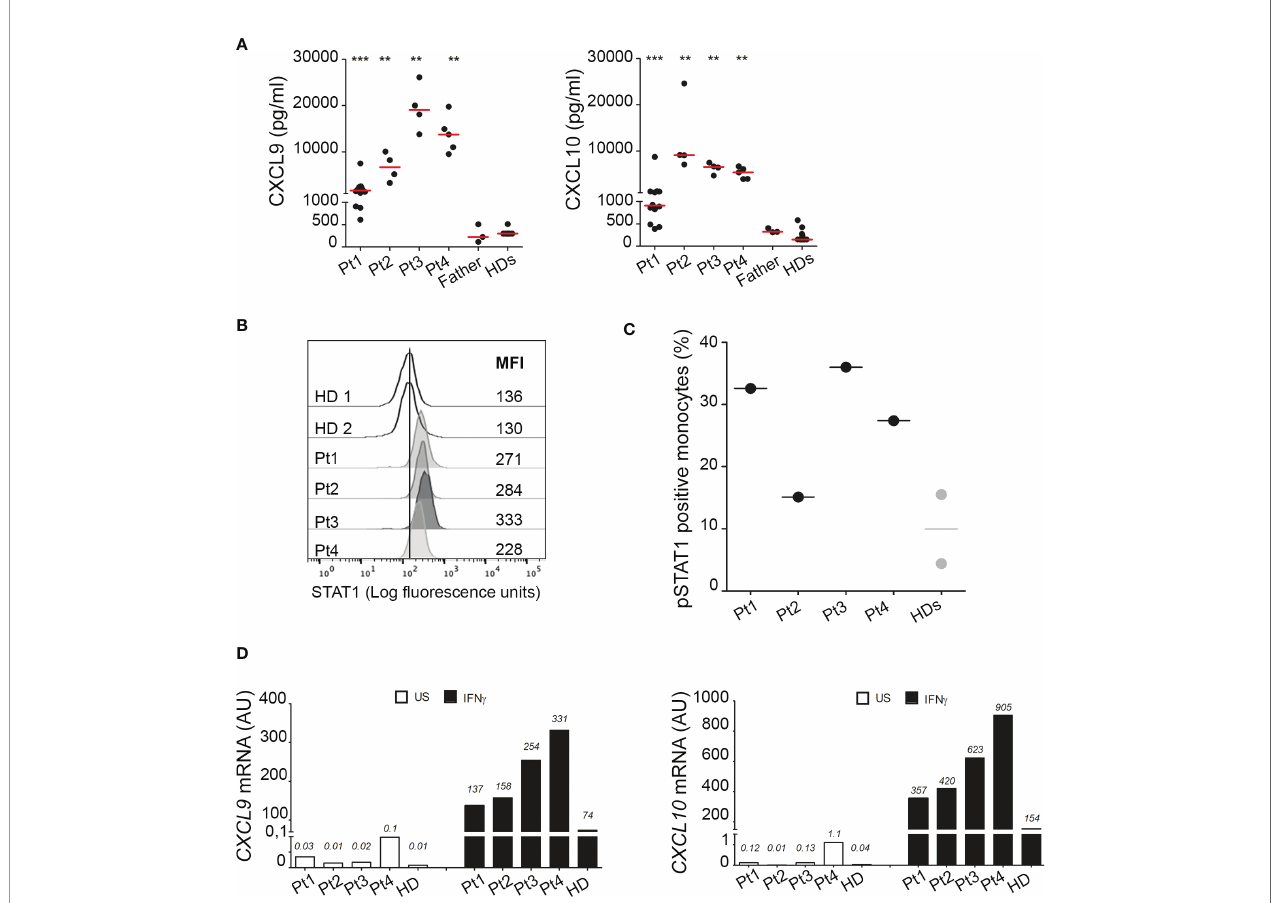
FIGURE 4 | Interferon gamma pathway is upregulated in HA20 patients. (A) CXCL9 and CXCL10 levels were measured in plasma samples collected from patients (Pt1-4) during different hospitalizations, from the father and from healthy donors (HD; n=15) by ELISA. Red bars indicate sample median. Statistical analyses were performed with Mann-Whitney test comparing each patient with HDs. **p<0,01; ***p<0,001. (B) Unstimulated PBMCs from patients (Pt1-4) and two healthy donors (HDs) were stained for total STAT1 levels. Results are reported as STAT1 mean fl uorescence intensity (MFI) in monocytes (CD14+ cells). (C) PBMCs from patients (Pt1-4) and two healthy donors (HDs) were stimulated for 10 minutes with 10 ng/ml of IFN g and phosphorylated STAT1 (pSTAT1) levels were detected by fl ow cytometry. Results were reported as % of pSTAT1 positive monocytes (CD14+ cells). (D) PBMCs from patients (Pt1-4) and one healthy donor (HD) were left unstimulated (US, white columns) or stimulated for 2 hours with 10 ng/ml of IFN g (IFN g , black columns) and CXCL9 and CXCL10 mRNA levels were analyzed by qPCR. Results were obtained after normalization with the housekeeping gene HPRT1 and were expressed as arbitrary units (AU). Similar results were obtained in two independent